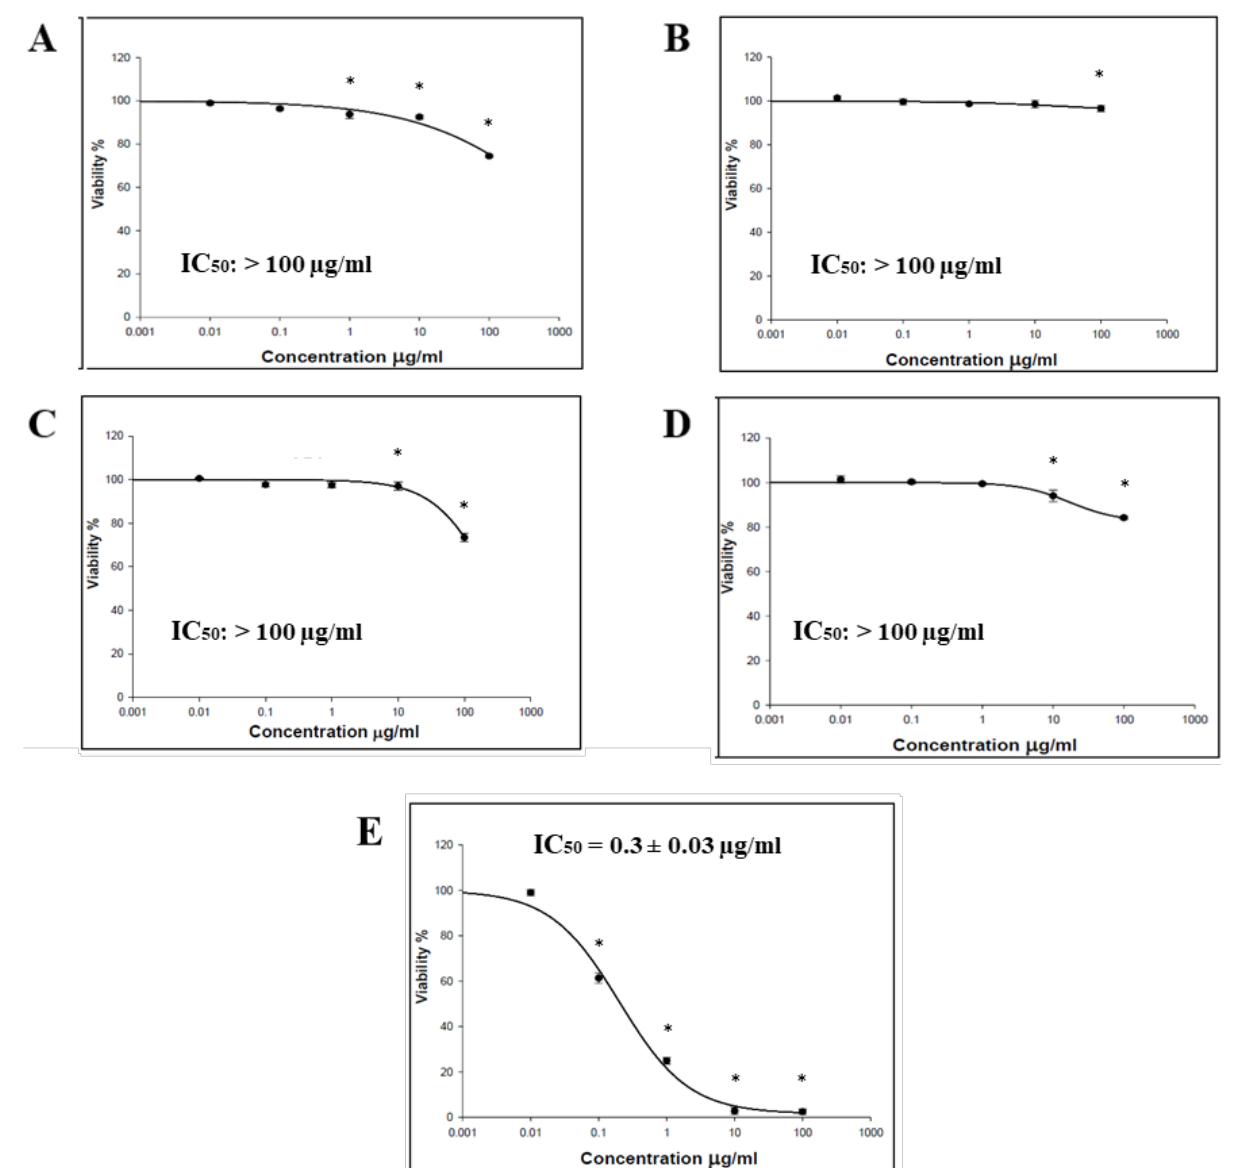
Figure 3. Representative dose–response plots demonstrating the effect of different O. baccatus methanolic extracts on MCF-7 cancer cell growth: ( A ) whole plant’s extract; ( B ) flowers’ extract; ( C ) branches’ extract; ( D ) roots’ extract; and ( E ) doxorubicin. The experiment was repeated three times. Dots and error bars represent mean ± S.D. * p < 0.05 vs. control .